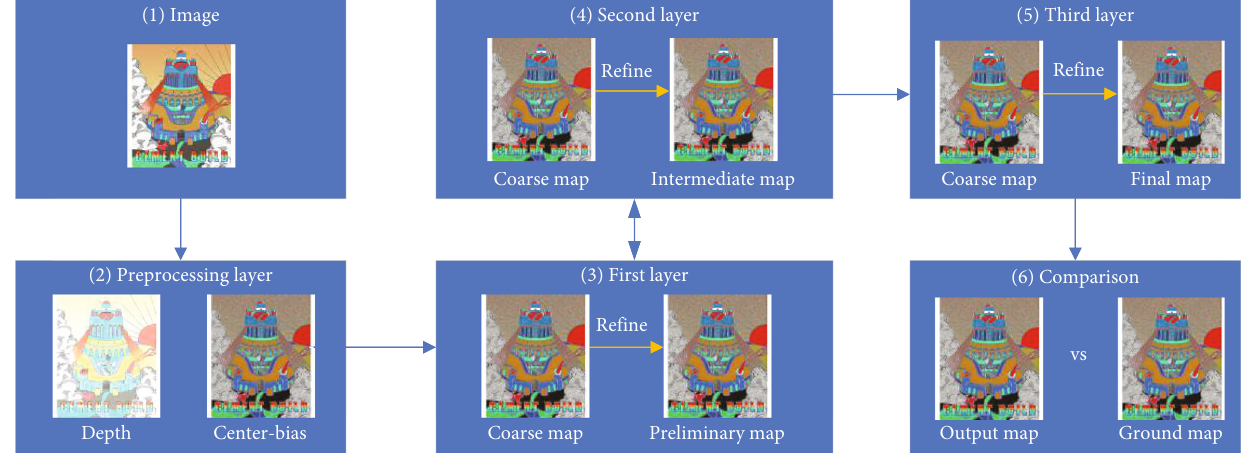
Figure 1: Framework of chaotic encryption and wavelet transform image